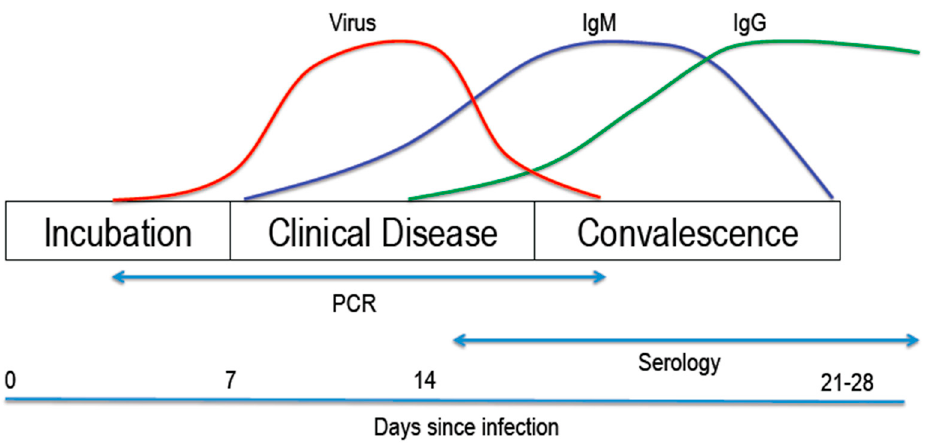
Figure 1. Detection of the virus in clinical specimens or detection of specific antibodies in blood. PCR: polymerase chain reaction, IgM: Immunoglobulin M; IgG: Immunoglobulin polymerase chain reaction, IgM: Immunoglobulin M; IgG: Immunoglobulin G.